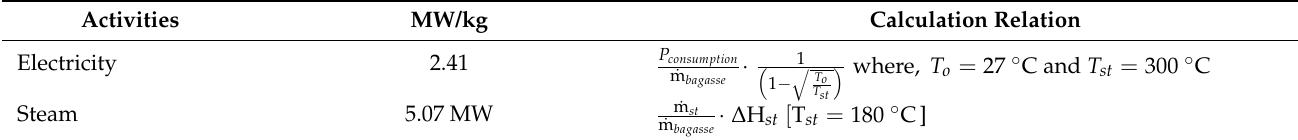
Table A2. Wet bagasse consumption to electricity generation and steam production (1 kg/s).